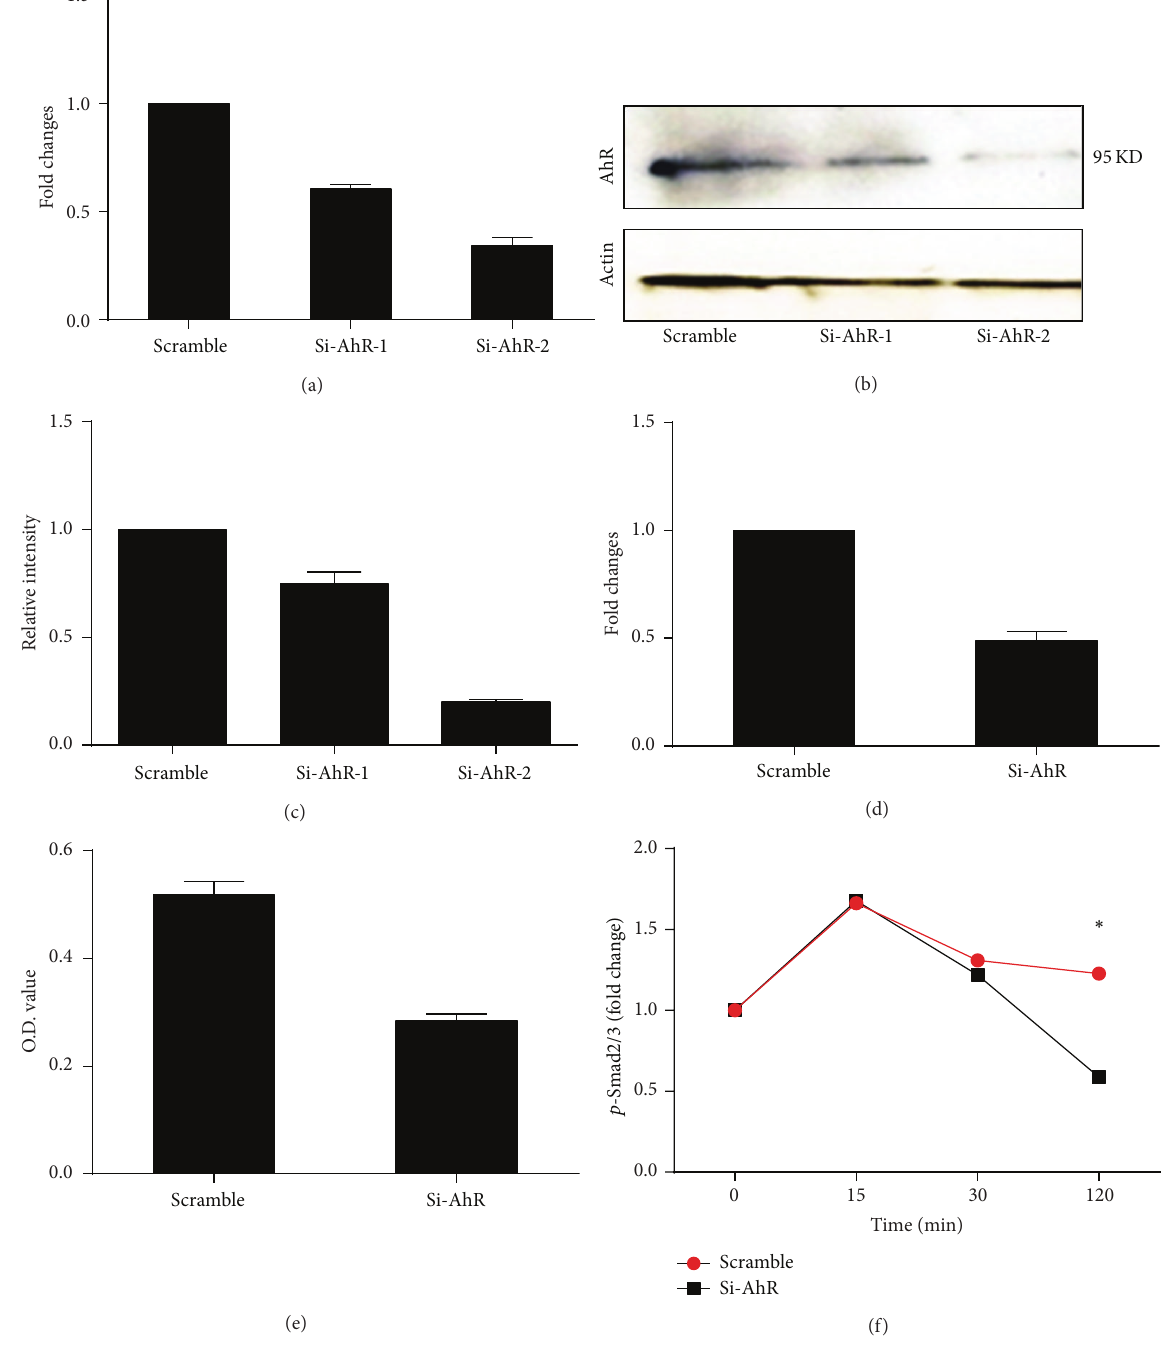
Figure 4: TGF 𝛽 1 production was reduced in fibroblasts with AhR knockdown by siRNA. (a–c) AhR knockdown by siRNAs was confirmed by RT-PCR (a) and western blotting (b). (c) AhR expression in (b) was quantified by ImageJ and normalized to those of 𝛽 -actin and then compared to scramble si-RNA treated group. (d) TGF 𝛽 1 expression in fibroblasts treated with scrambled siRNA and si-AhR. (e) Levels of secreted TGF 𝛽 1 stimulated with CRE by fibroblasts treated with scramble si-RNA and si-AhR. (f) WI38 cells were stimulated with 5 ng/mL TGF 𝛽 1 for indicated time after AhR knockdown for 48 h; p-Smad2/3 was detected with flow cytometry. Bars represent mean ± SEM of 3 independent experiments. ∗ 𝑃 < 0.05 , ∗∗ 𝑃 < 0.01